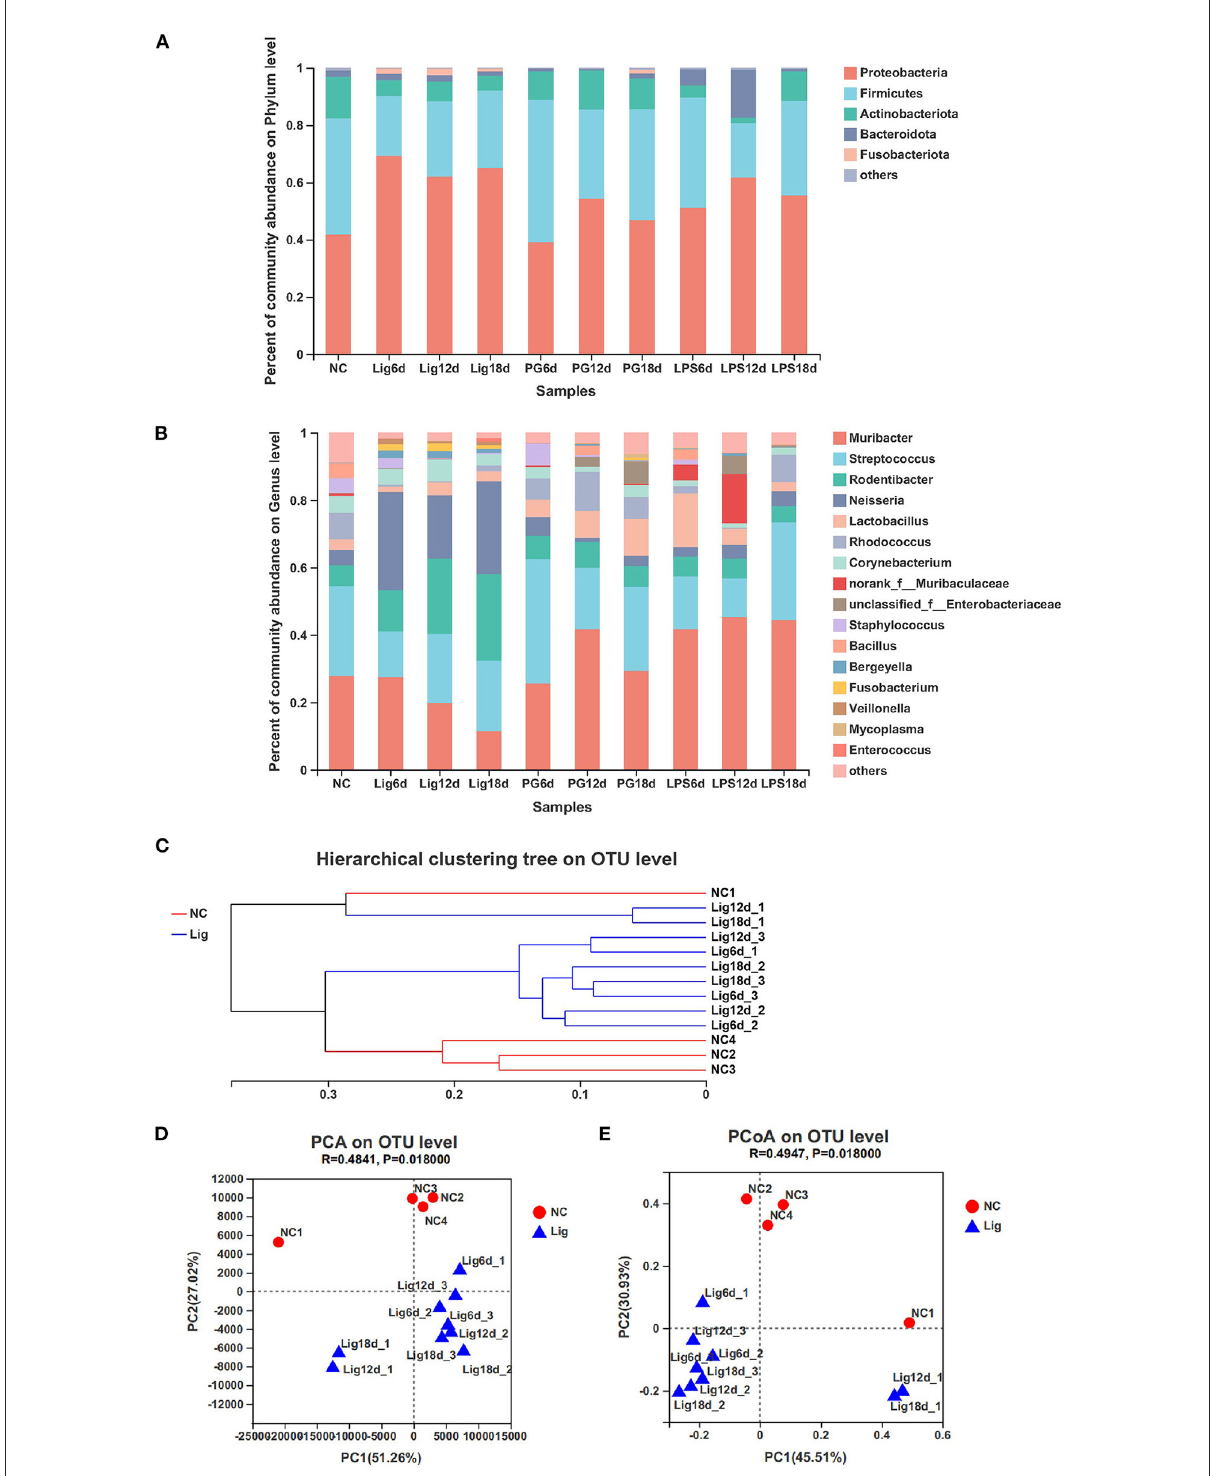
FIGURE3 Composition and β diversity of bacterial communities in the orthodontic wire ligation model. (A,B) Relative abundance of bacterial phyla and genera identified in mouse oral cavities after ligation treatment. (C) Bray-Curtis hierarchical clustering showing the relationship between samples. (D) Principal component analysis of bacterial community composition in mouse oral cavities based on ANOSIM. (E) PCoA analysis based on Bray-Curtis distancesfor bacterial community compositionsin the